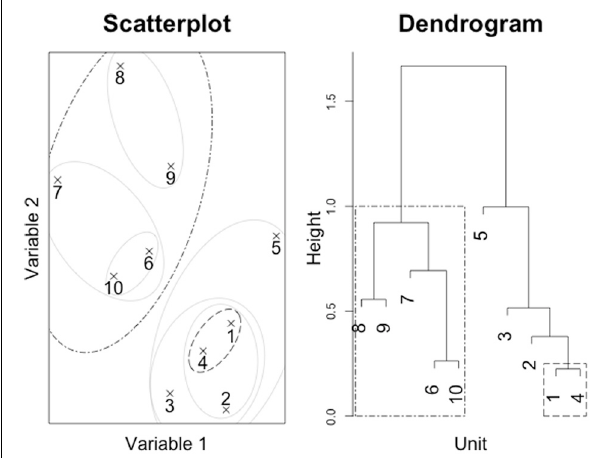
FIGURE 1 | Clustering of artificial data and dendrogram. Light gray ellipses indicate clusters, while the dark, dotted ellipses indicate the corresponding clusters in the